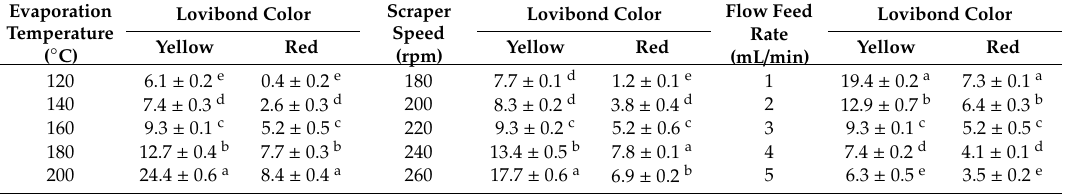
Table 2. E ff ect of molecular distillation parameters on the Lovibond color of EAE-produced soybean oil. Evaporation